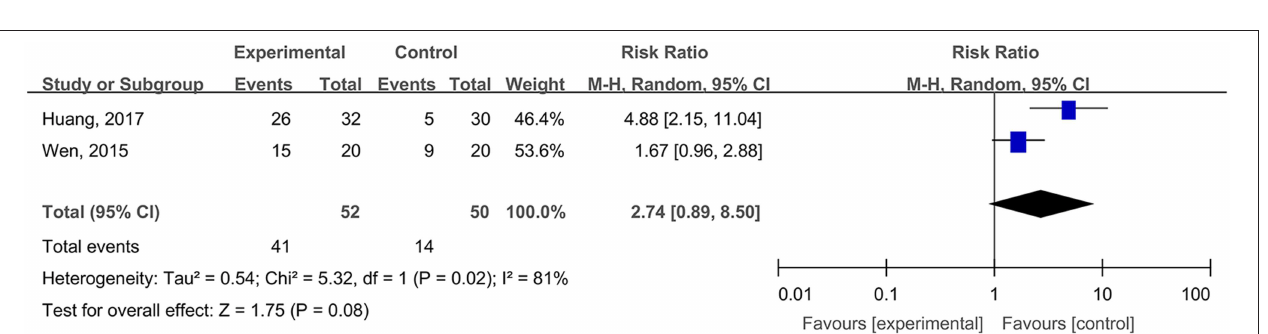
was shortened by 9.46 days as compared with that of the control group and that the difference had a high statistical significance (MD = − 9.46, 95% CI: − 10.90 to − 8.01, P <